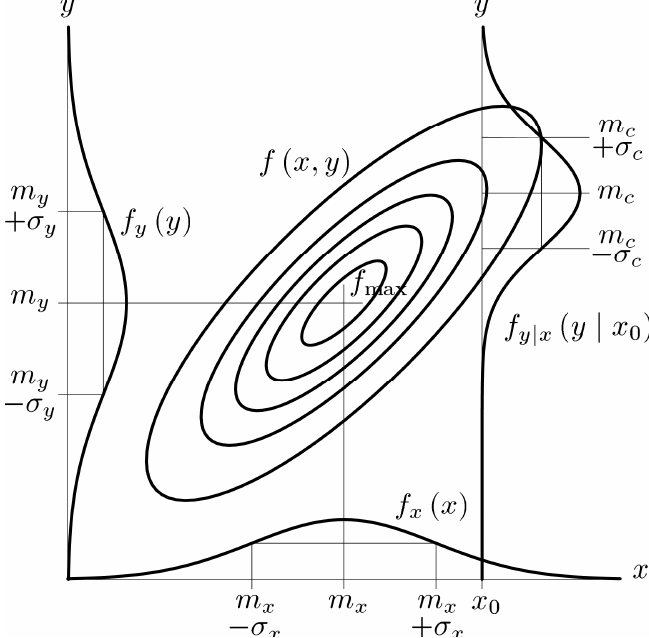
Figure A1. The joint probability density f ( x , y ) of the couple of random variables ( X , Y ) is plotted using contour levels (at level 0.9 · f max , 0.7 · f max , 0.5 · f max , 0.3 · f max and 0.1 · f max ), the marginal probability densities for the variables themselves ( f x ( x ) for X and f y ( y ) for Y ) are plotted on the x and the y axes. The value x 0 = 1.5 has been fixed and the conditional probability density f c ( y ) = f y | x ( y | x 0 ) is plotted, the mean m x = m y = 0 and m c has been reported as the standard deviation σ x = σ y = 1 and σ c , the correlation ρ = 0.8 appears only in the ellipticity of the ellipses for the joint p.d.f. f . As Equation (A17) shows, the number of free parameters of the couple ( X , Y ) is 1 + σ c σ y